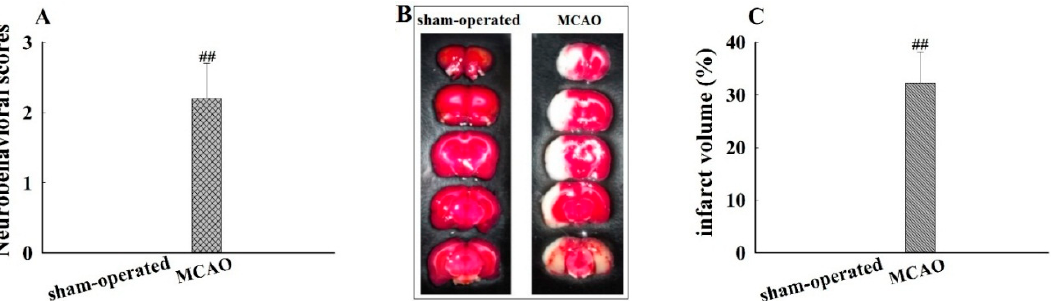
Figure 2. Neurobehavioral disability and infarct regions caused by middle cerebral artery occlusion I/R injury (MCAO), evaluated by neurobehavioral scores and 2,3,5-triphenyltetrazolium chloride (TTC) staining. ( A ) Neurobehavioral scores; ( B ) TTC staining of brain; and ( C ) infarct volume (%). Rats exposed to 1 h ischemia followed by 24 h reperfusion to establish MCAO model. Neurobehavioral disability of rats was assessed ( n = 12), and brain tissues were collected for TTC staining ( n = 6 ). Data are mean ± standard deviation (SD), ##: p < 0.01 for MCAO vs. sham-operated group.